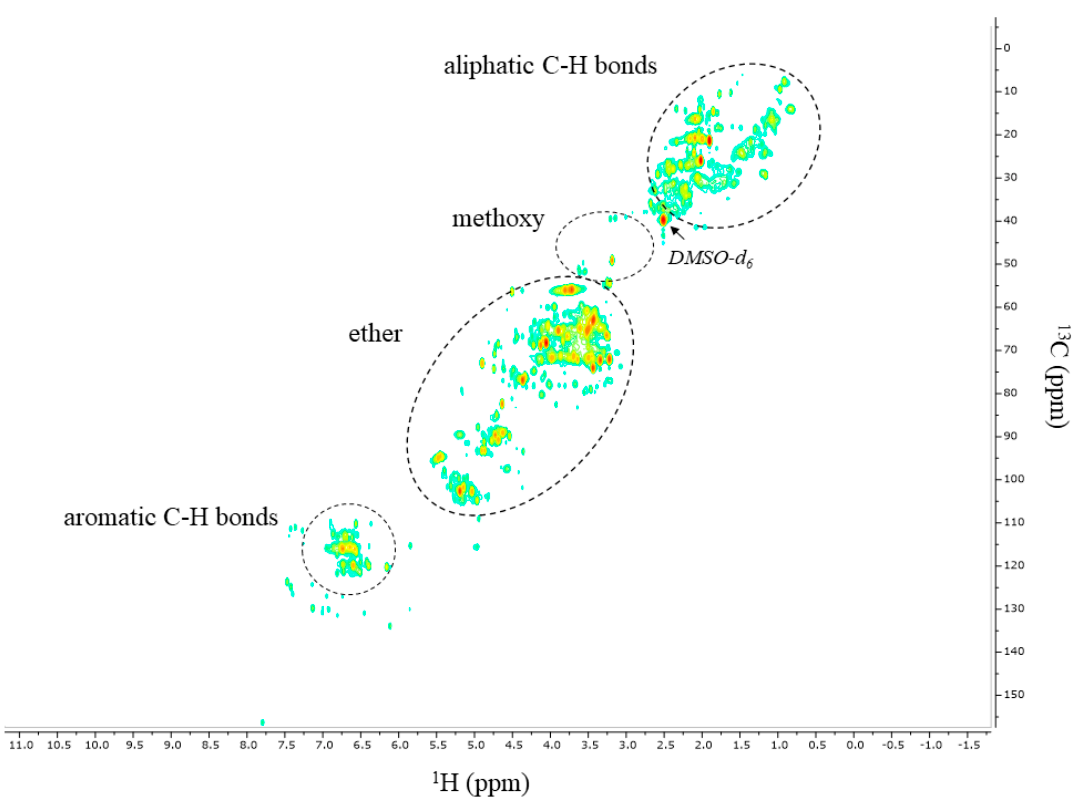
Figure 8. 2-D HSQC-NMR spectrum of bio-oil obtained from pigeon pea wood pyrolysis at optimized conditions, showing the aliphatic C–C, methoxy, ether and aromatic C-H groups.